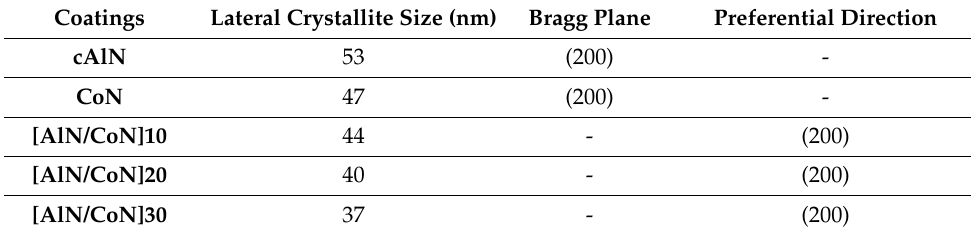
Table 1. Crystallographic lateral crystallite size for AlN, CoN [AlN/CoN]n materials.